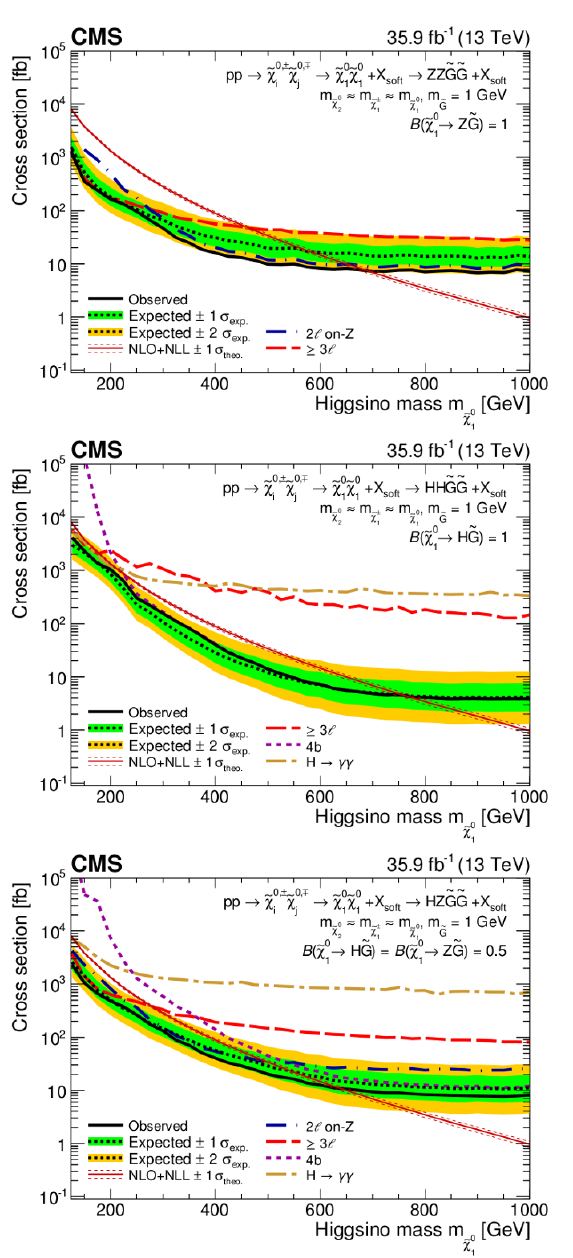
Figure 14 . The 95% CL upper limits on the production cross sections as a function of m model of (cid:31) 0 (cid:31) 0 production with three choices of B ( 1 1 (middle) 100%, yielding the HH topology, and (lower) 50%, yielding the ZH mixed topology. The solid black line represents the observed exclusion. The dashed black line represents the expected e e exclusion, while the green and yellow bands indicate the (cid:6) 1 and 2 (cid:27) uncertainties in the expected limit. The red line shows the theoretical cross section with its uncertainty. The other lines in each plot show the observed exclusion for individual analyses.